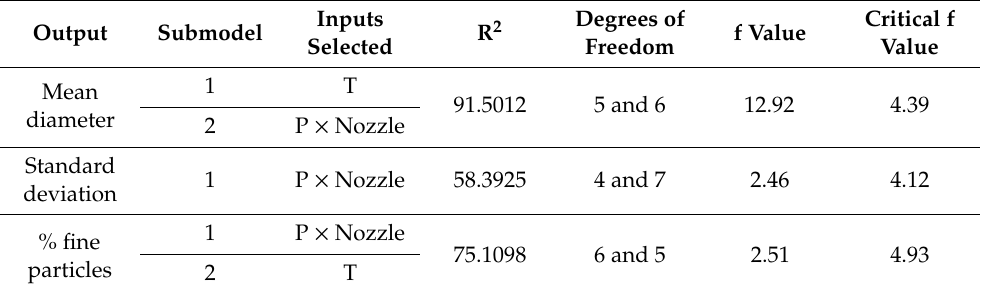
Table 2. Inputs selected by FormRules ® for the di ff erent outputs evaluated in this work, with their respective parameters to evaluate the quality of each model. The most relevant submodels are highlighted in bold.